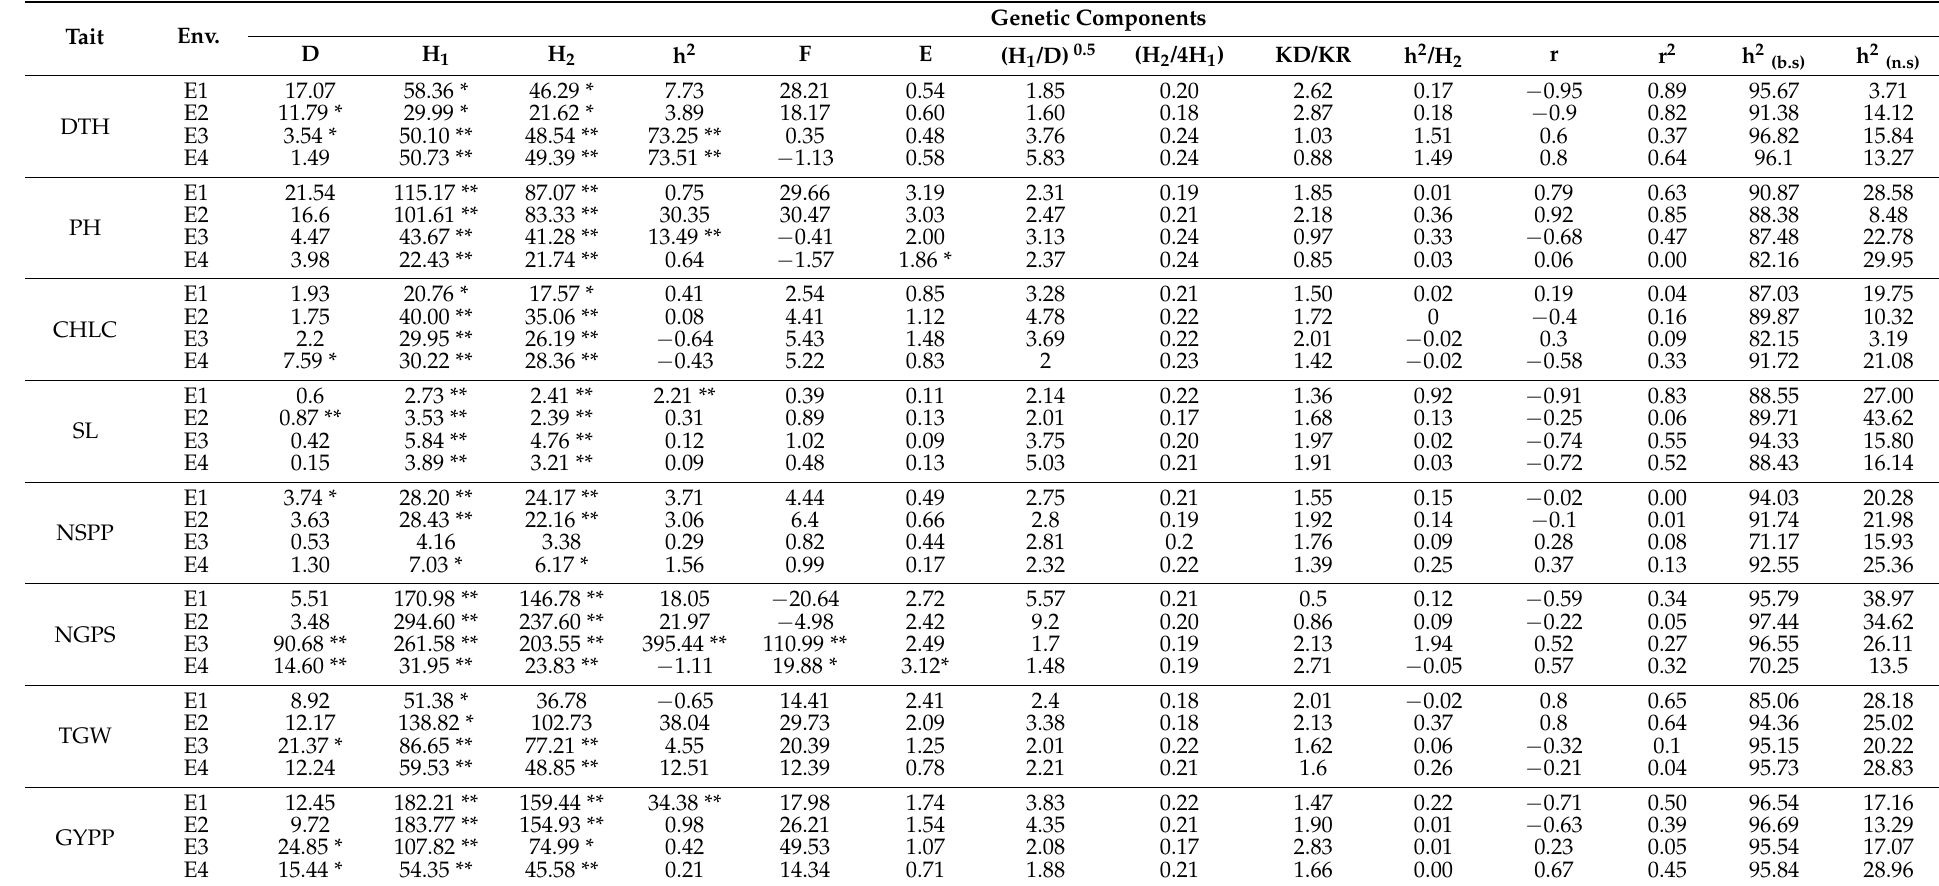
Table 5. Components of genetic variance for all the evaluated traits under tested